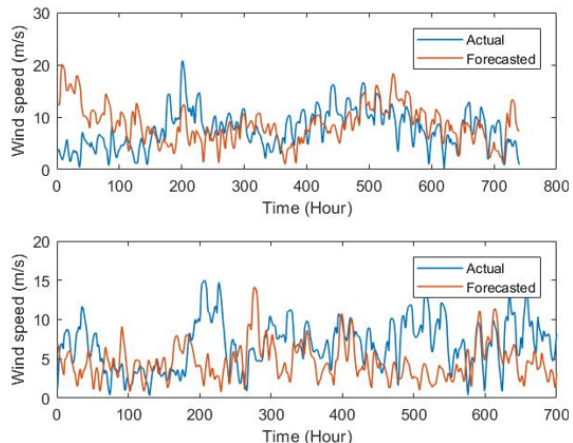
Figure 18. Forecasted and actual wind speeds of 2017 Jun & Jul, Khafji, Case